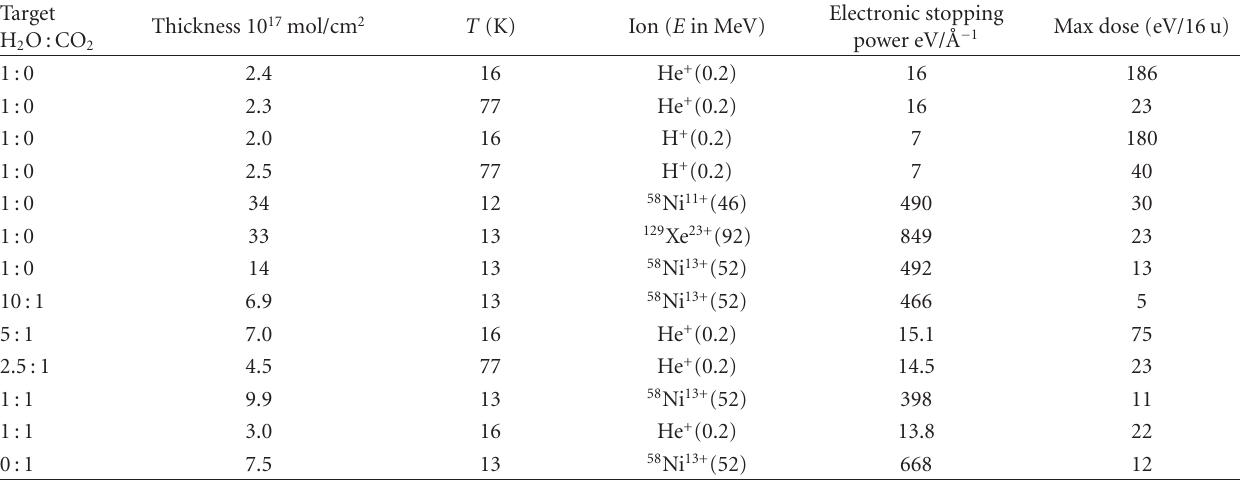
Table 1: Summary of the experiments discussed in this paper.